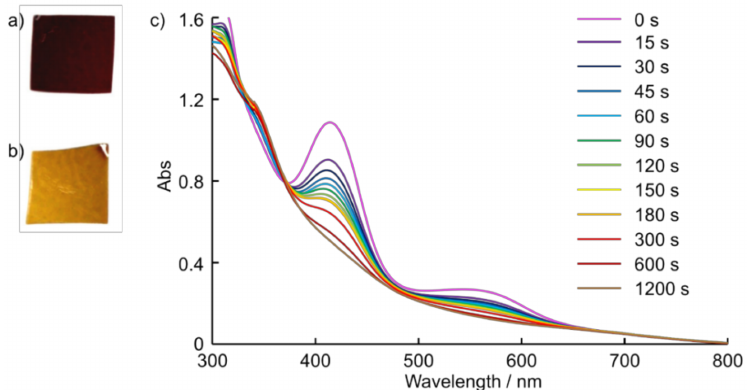
Figure 4. Photographs of ( a ) 1c /polysiloxane self-standing composite film (thickness: 0.555 mm) and ( b ) 2c /polysiloxane composite film, which was prepared by exposure of the 1c /polysiloxane composite to CO gas. ( c ) UV-Vis spectral changes of the 1c /polysiloxane self-standing composite film during exposure to CO gas.